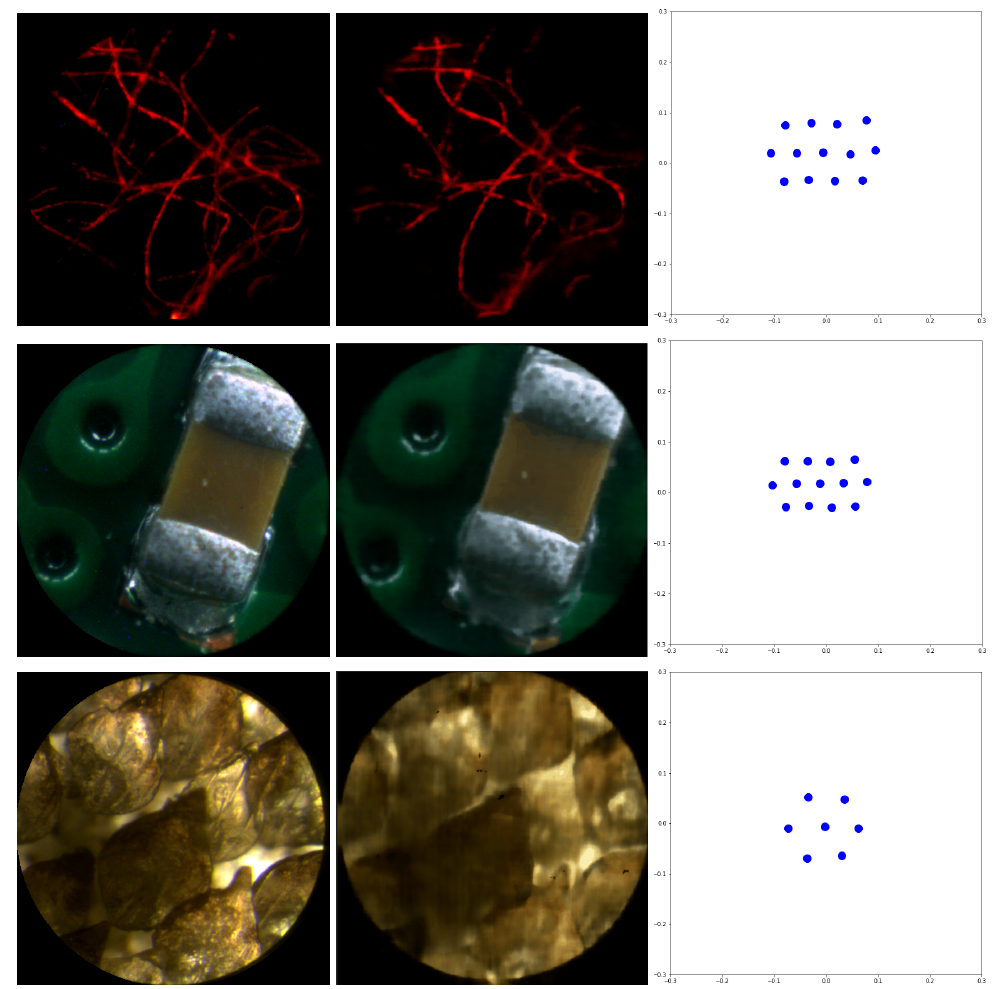
Figure 6. ( Left column ) Acquired elemental image; ( central column ) synthesized image; ( right column ) 2D inferred positions of the capturing cameras (blue full